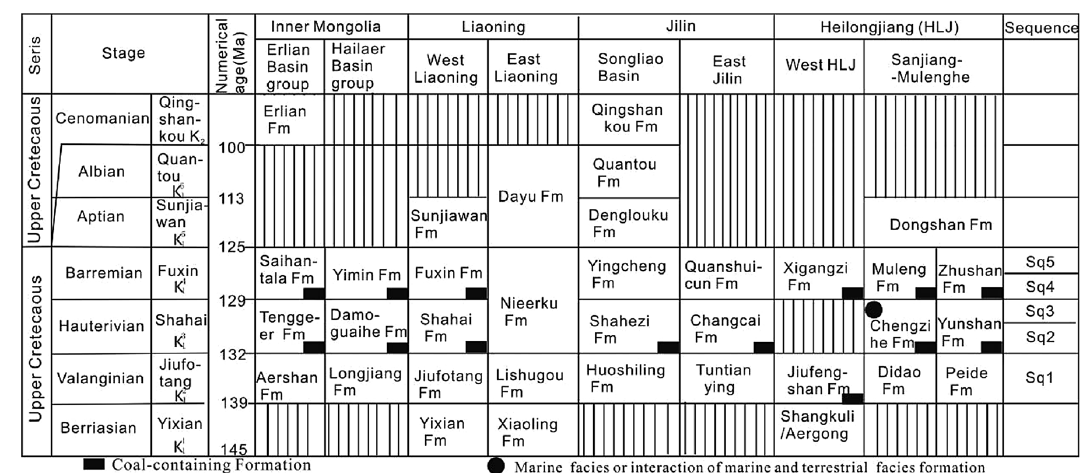
Fig. 15 The stratigraphic correlation and sequence stratigraphic framework of the Early Cretaceous in the Northeast China CAA. Revised from Wang et al. (1997), Sun and Zheng (2000), Shao et al. (2013a, b)